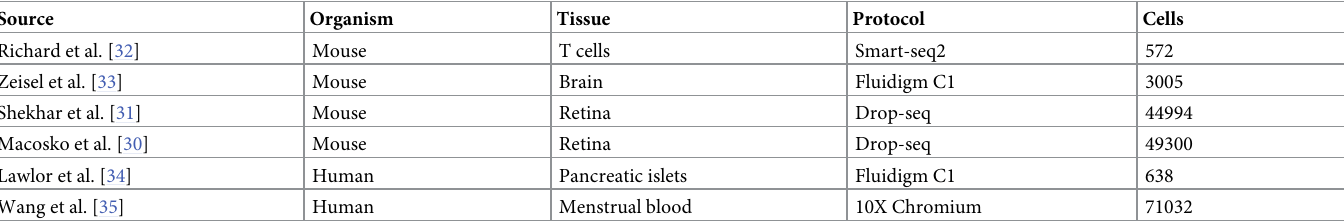
Table 1. Description of non-cancer tissue scRNA-seq datasets. Columns from left to right include the source, the organism, the type of tissue, the experimental protocol, and the number of cells prior to QC in each dataset.